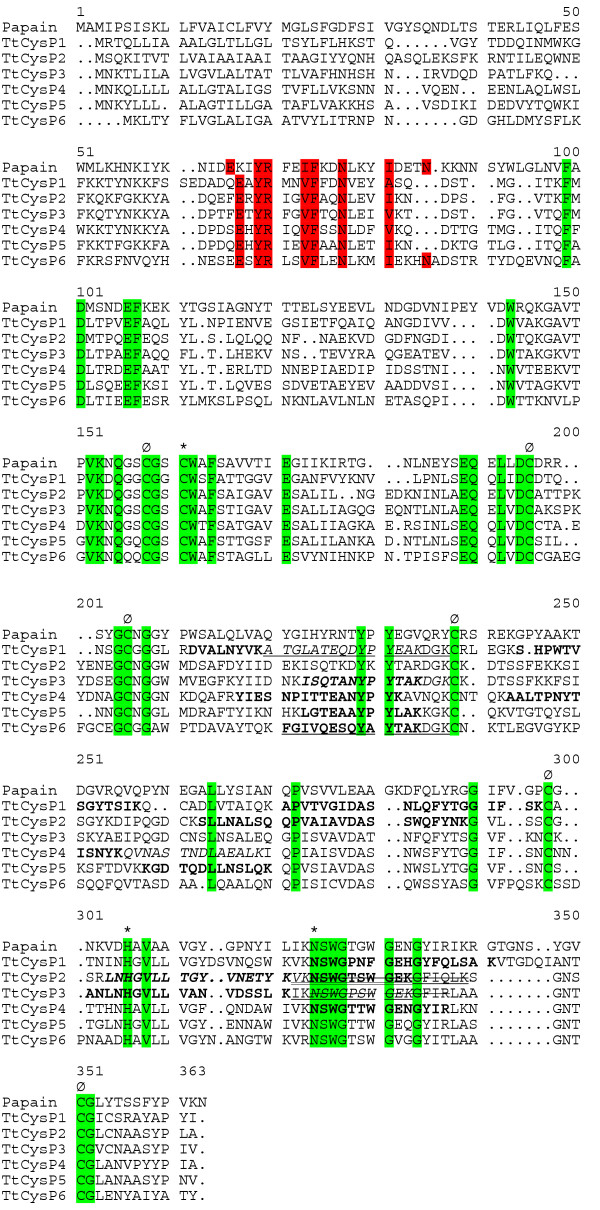
Sequence alignment of T. thermophila extracellular proteases. The identified cysteine proteases in T. thermophila supernatants are compared to papain. The ERFNIN motif is highlighted in red, amino acids that are conserved in all enzymes are green. Amino acids of the catalytic center are marked by *, cysteines that form disulfide bridges by ∅. All peptides found by mass spectrometry in the different proteases are highlighted by either bold, italic, underlined, or doubly underlined letters. Obviously no N-terminal peptides were detected, as only secreted, mature enzymes with cleaved off prepro-peptides (~aa 1-140) were analysed. Peptides around aa 160 are not expected either as the catalytic cysteine that covalently bound to DCG-04 resides at this position.